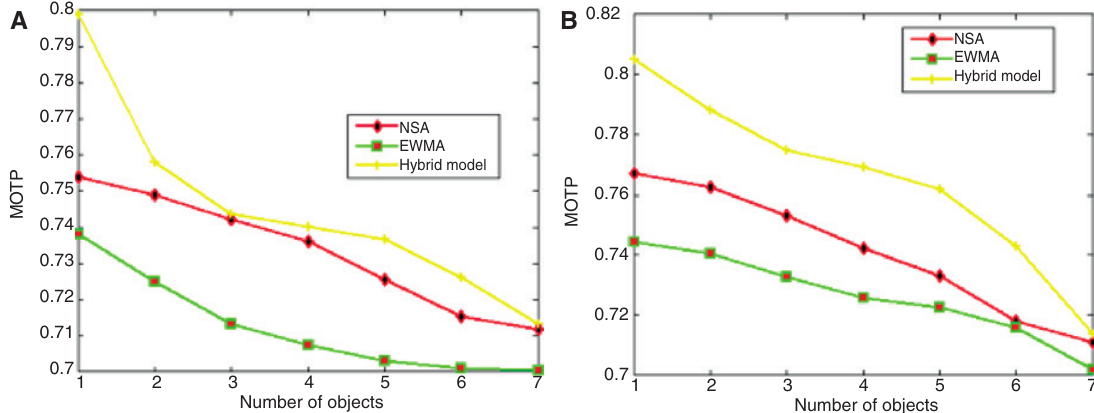
Figure 6: Performance Analysis of Object Tracking in (A) Video 3 and (B) Video